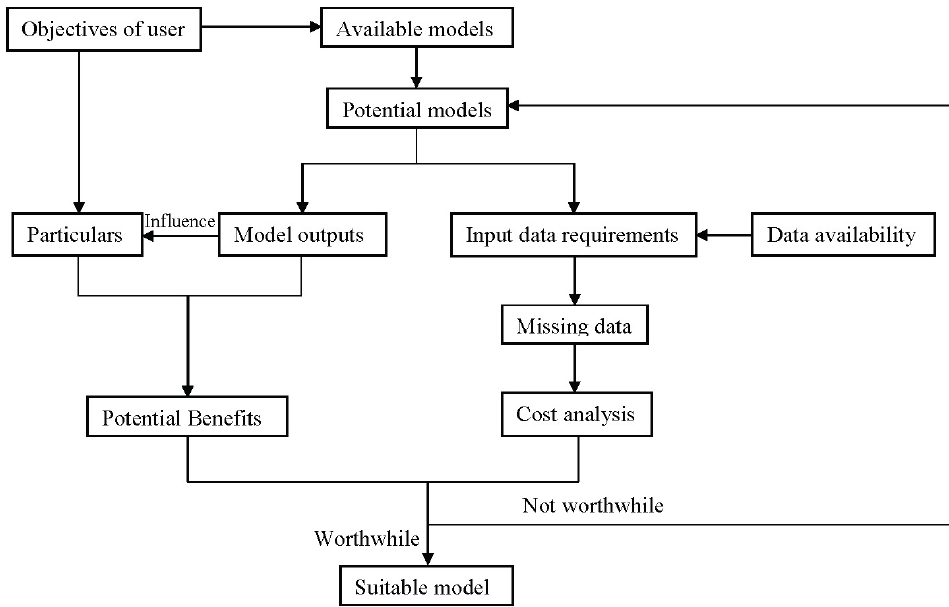
Figure 5. Scheme of the model selection